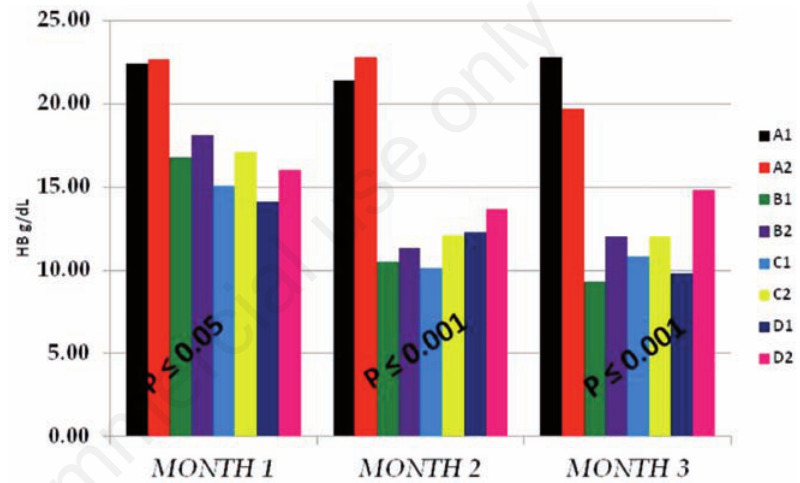
period.Figure 2. The hemoglobin (HB g/dL) mean values of the different subgroups for the 3 months study